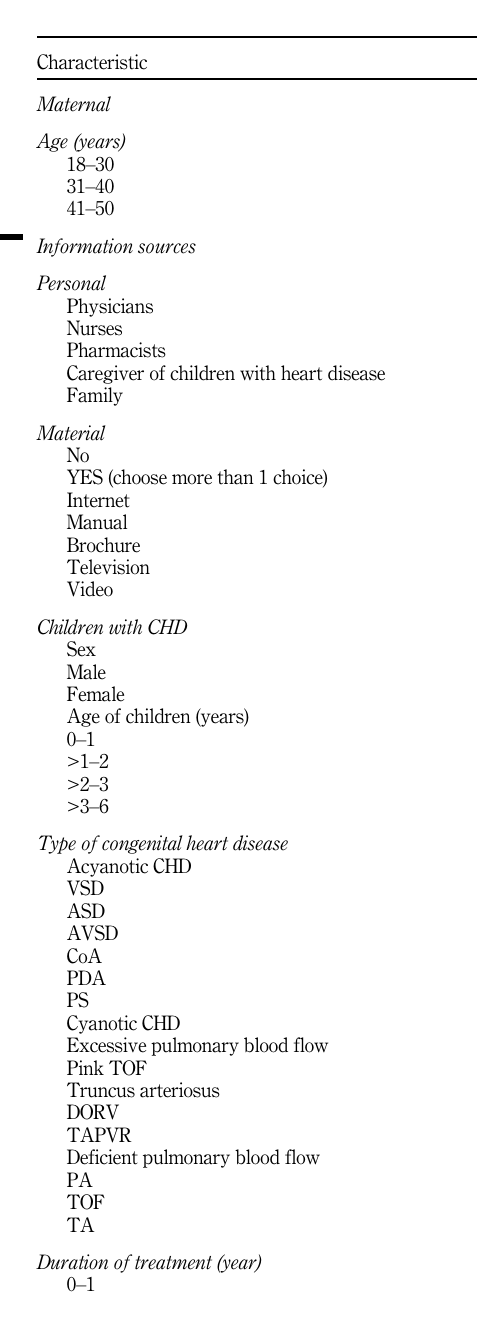
Table 1. Characteristics of